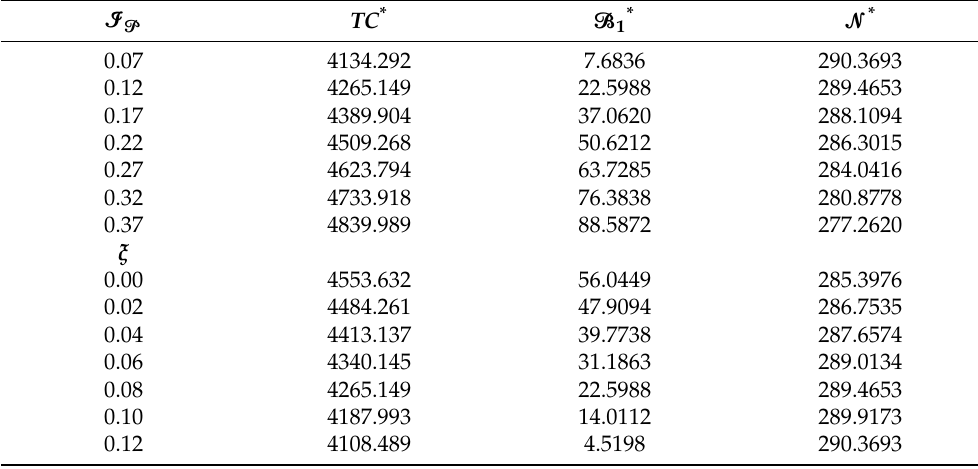
Table 3. The effect of changes in the interest rate (cid:73) (cid:80) and the discount rate ξ on arriving at optimal total cost and optimal ordering